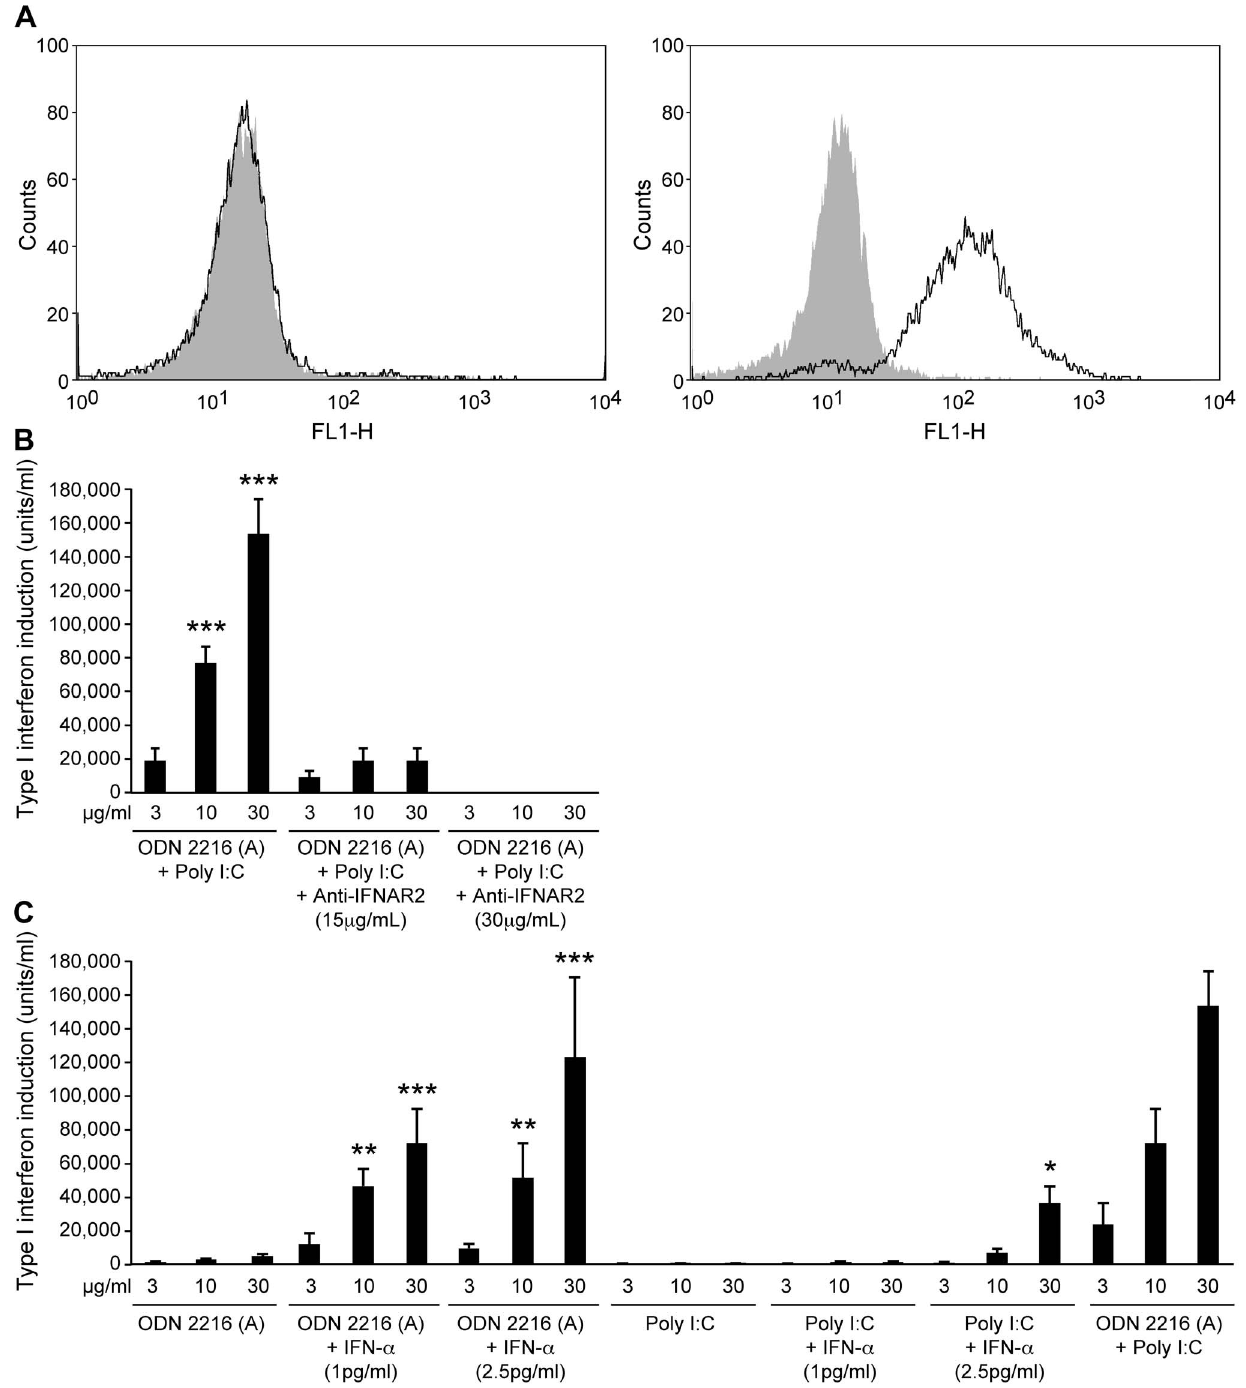
Figure 2. Synergistic effect of ODN 2216 and poly I:C depends on positive feedback regulation of type I interferon induction via the interferon receptor. (A) Spleen cells from cotton rats were stimulated with Concanavalin A for 72 hours and lymphoblasts purified by centrifugation on a ficoll-gradient. Subsequently, cells were stained with antisera specific for the human interferon receptor to test for crossreactive binding to cotton rat cells and analyzed by flow cytometry. Antibody specific for human interferon alpha receptor-1 (IFNAR-1) did not react with cotton rat cells (left) whereas antibody specific for human interferon alpha receptor-2 (IFNAR-2) did (right). IFNR specific antibody is shown as black line, controls as gray areas. B. IFNAR-2 antibody was added to cotton rat spleen cells. One hour later different concentrations of a combination of ODN2216 and poly I:C was added. 24 hours later supernatant was harvested and tested for the presence of type I interferon. The data is combined from two independent experiments. Significant differences were seen between cells treated with the combination of ODN2216 and poly I:C alone, or the combination of ODN2216 and poly I:C with antibody. IFNAR-1 antibody (not reactive with cotton rat cells) had no effect. C. Cotton rat spleen cells were stimulated with ODN 2216 or poly I:C, with or without the addition of recombinant cotton rat interferon alpha. (One unit equals one picogram of type I interferon.) 24 hours later supernatant was harvested and tested for the presence of type I interferon. The data is combined from two